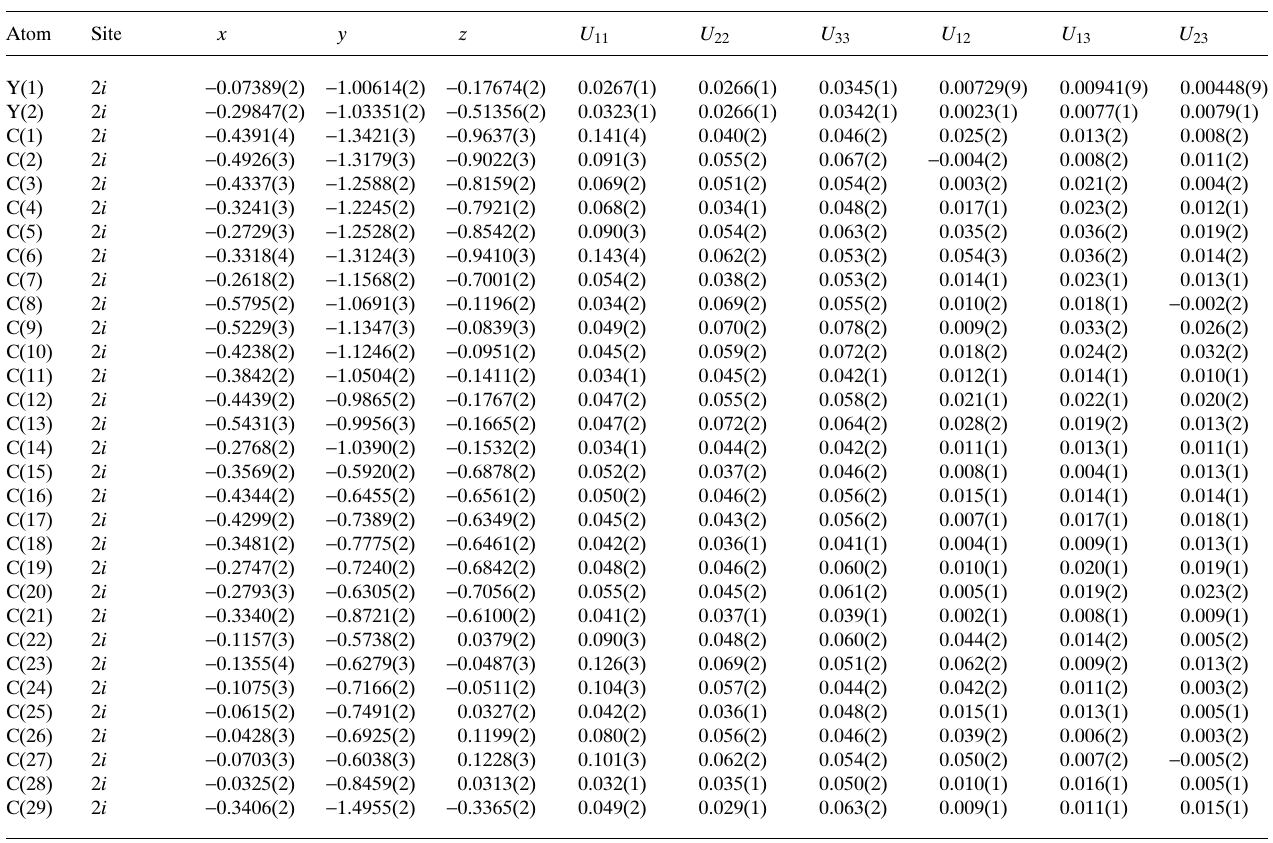
Table 3. Atomic coordinates and displacement parameters (in Å 2 ) .